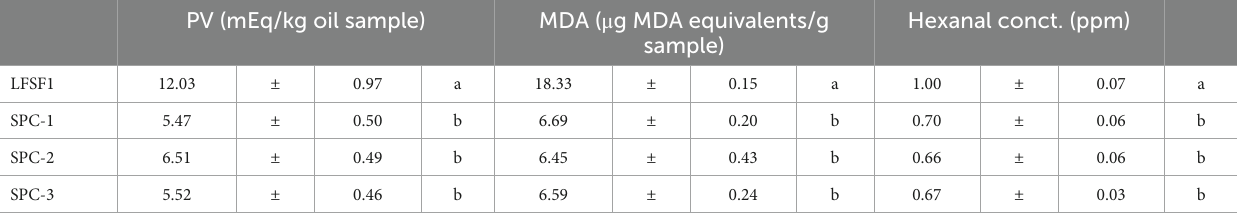
TABLE 3 Peroxide value, malondialdehyde, and hexanal concentration of LFSF1 raw material and three batches of its SPCs at the large-scale production trials (30 min 22 ° C).